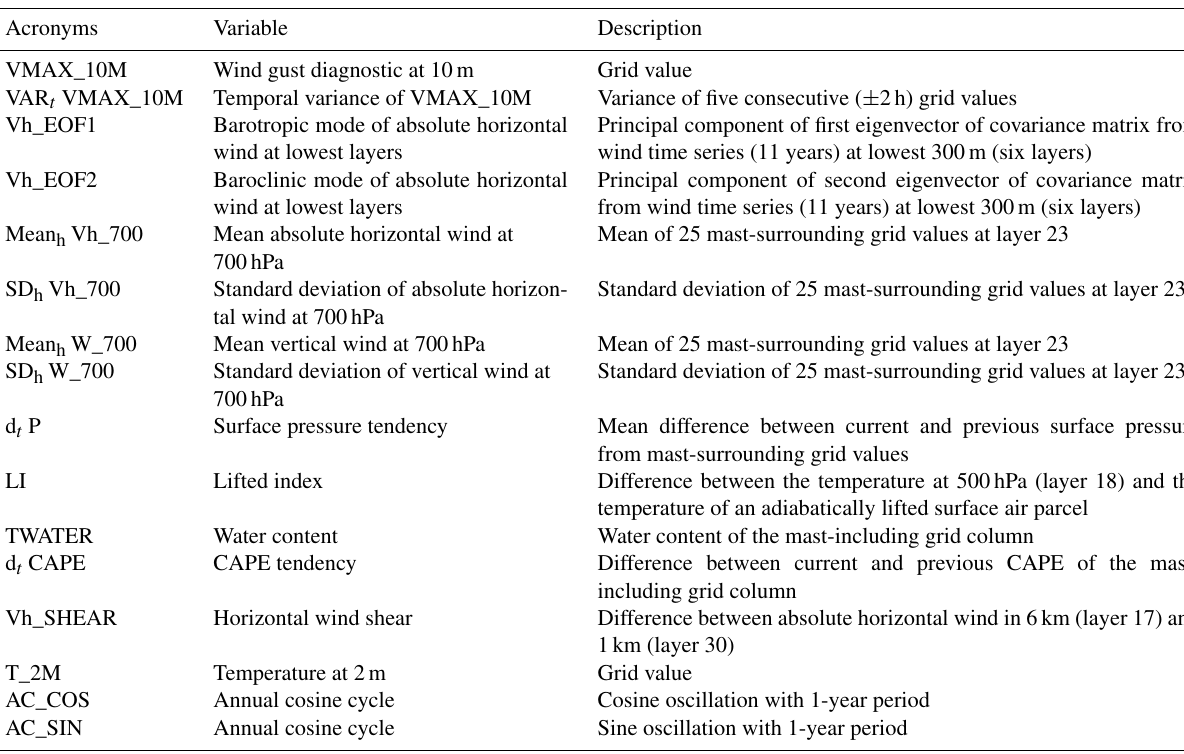
Table 1. List of preselected covariates from the COSMO-REA6 reanalysis.